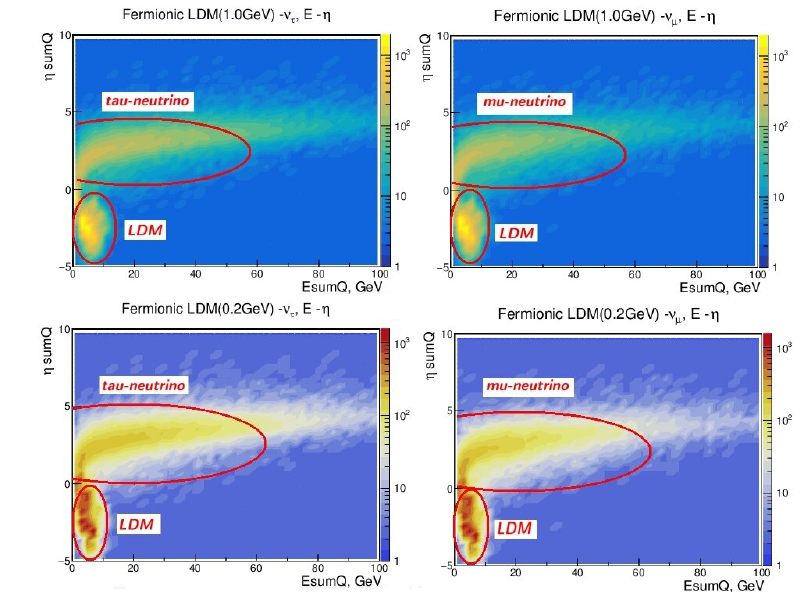
Figure 11. Distributions of the total energies and pseudorapidities of charged particle systems of LDM and neutrino